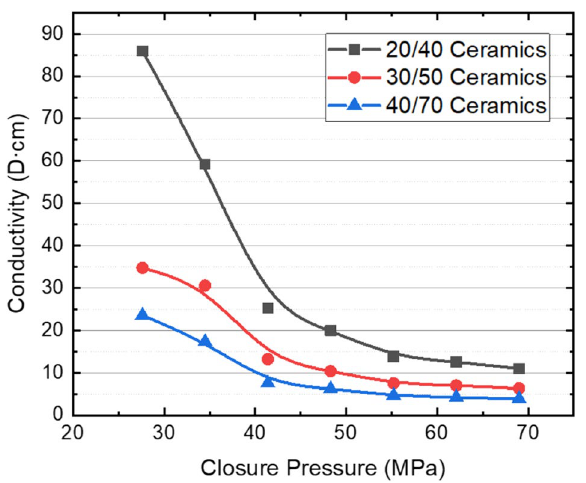
Figure 3. Fracture conductivity of ceramic proppants using reservoir rock plates with a concentration of 8 kg/ m 2 .